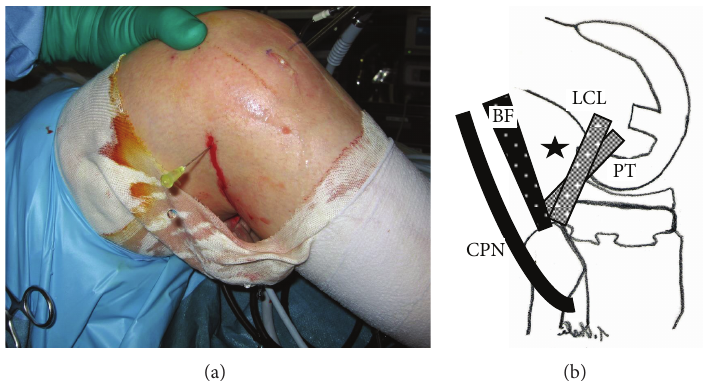
Figure 3: (a) Operative procedure to determine the site of the posterolateral portal. A 22-gauge needle was inserted at the edge just posterior to the lateral aspect of the femoral component. (b) The black star indicates the position of the posterolateral portal. BF: biceps femoris; CPN: common peroneal nerve; LCL: lateral collateral ligament; PT: popliteus tendon.